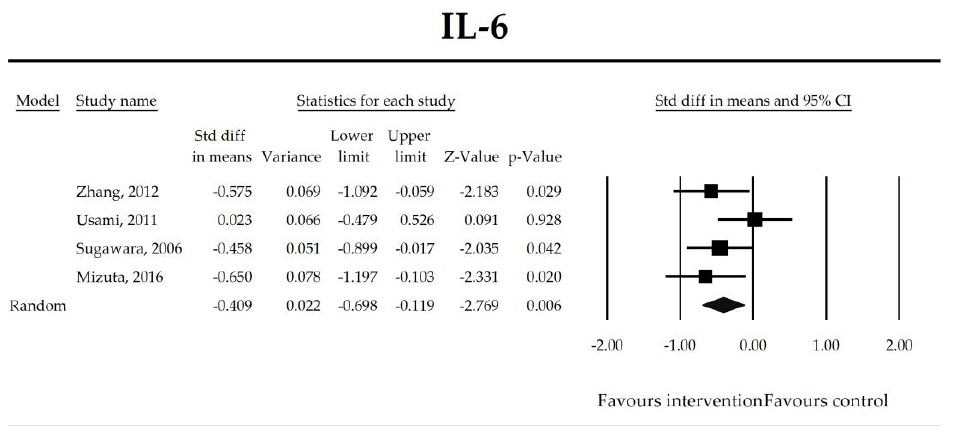
Figure 2. The effect size (standardized mean difference) for the concentration of CRP in patients taking probiotics (intervention) vs. no probiotics (control).